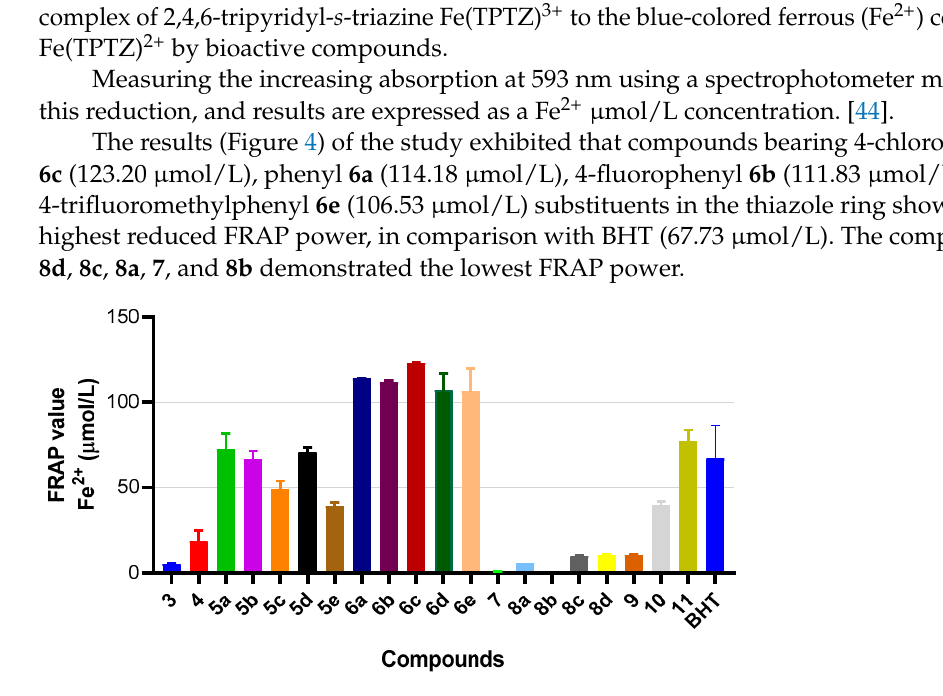
Figure 4. The ferric-reducing antioxidant power activity of 3 – 11 compounds and synthetic antioxi- dant BHT. Data are shown as mean ± SD from three experimental replicates. DPPH radical-scavenging assay. The 1,1-Diphenyl-2-picrylhydrazyl (DPPH•) radi-